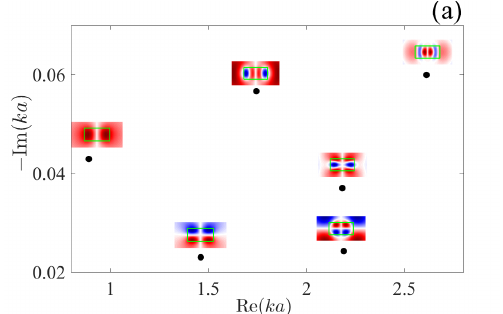
Figure 10: The resonant eigenfrequencies (close circles) and corresponding resonant modes (the component E ϕ of isolated dielectric disk with the height h = a and permit- tivity ϵ = 40 .